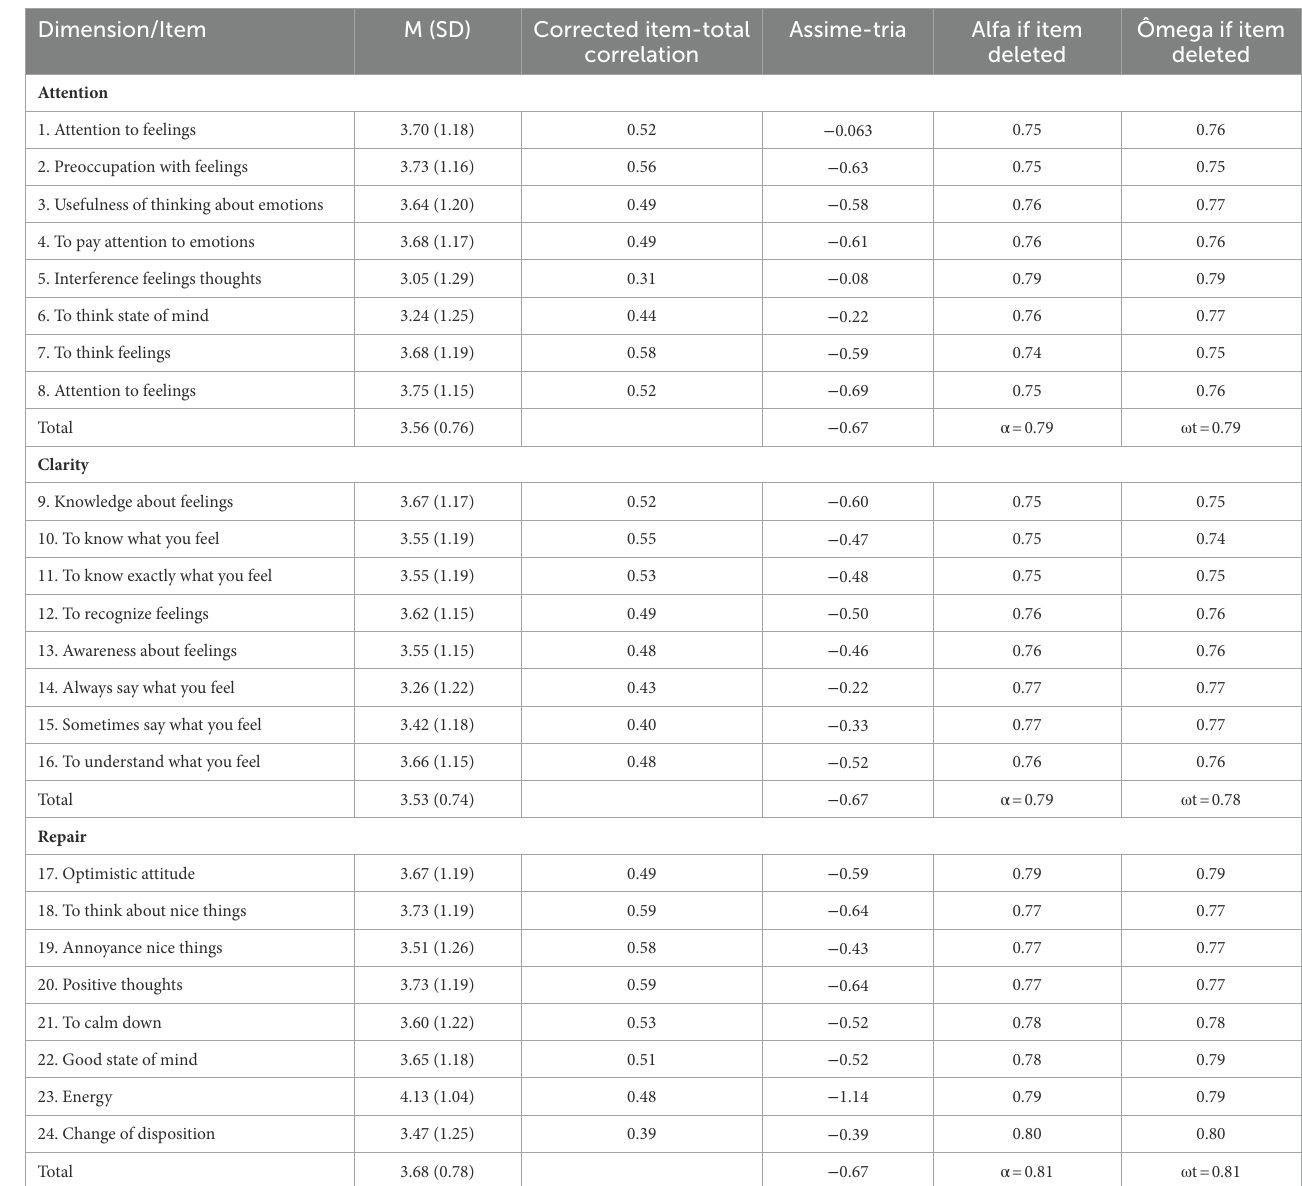
TABLE 3 Descriptive statistics and internal consistency of the items and dimensions of the TMMS-24 (RS, 2013–2018; n = 4.681).